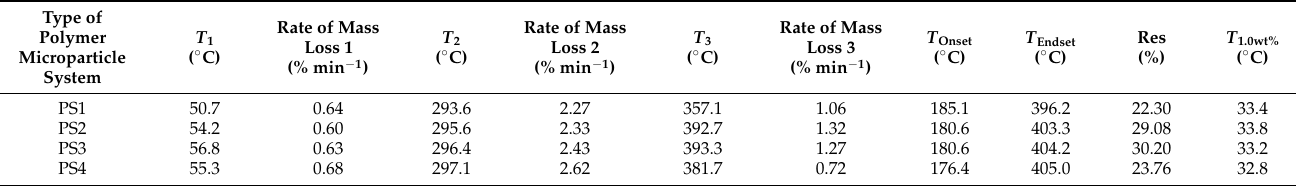
Table 3. The characteristic thermal degradation parameters of PS1, PS2, PS3, and PS4 at 5 ◦ C · min − 1 in a nitrogen atmosphere at 50 mL min − 1